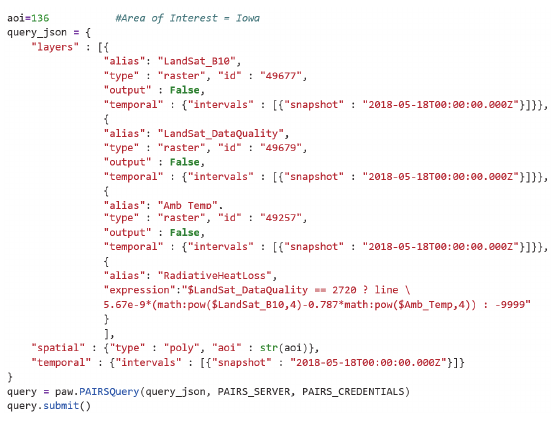
Figure 3: An example of a user-defined function submitted within the